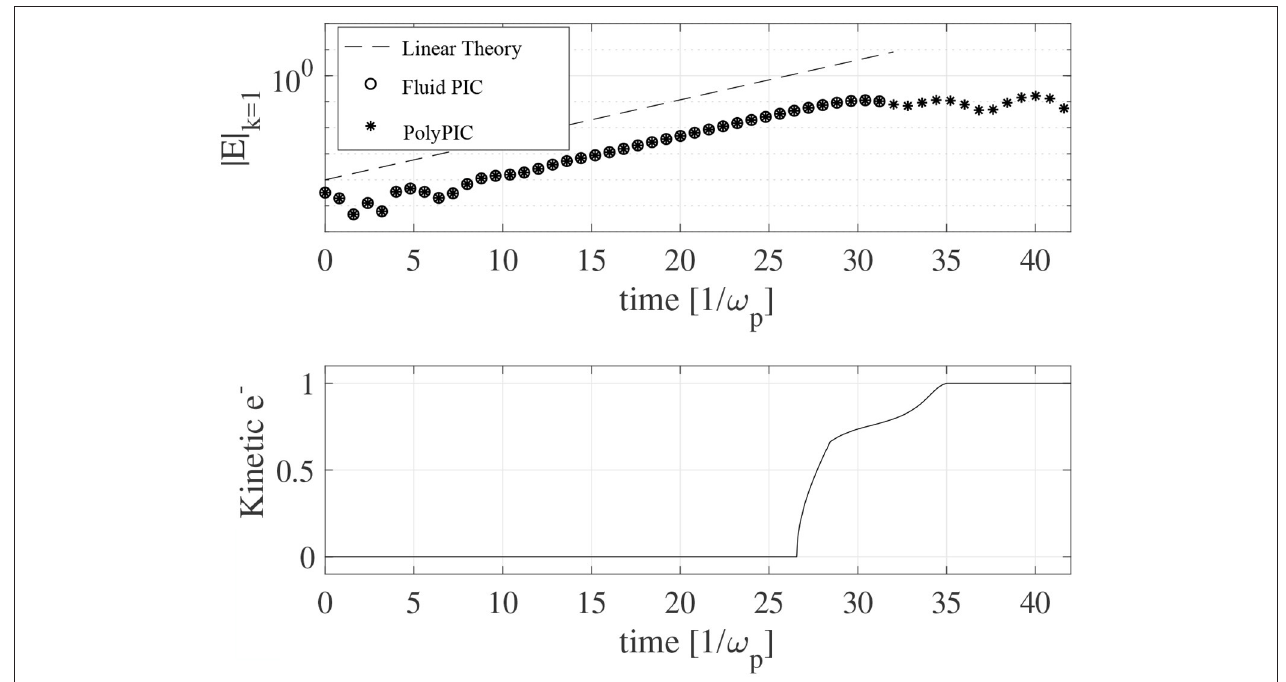
FIGURE 7 | The k 1 spectral component of the electric field is shown for two fluid PIC simulation (open circles), PolyPIC simulation (asterisks) and linear theory = (dashed line) in the top panel. The two fluid PIC simulation becomes unstable during the non-linear stage of the instability. The bottom panel shows the ratio of kinetic electrons over the total number of electrons during the PolyPIC simulation. Initially, all the electrons are fluids; during the non-linear phase of the instability, the electrons become kinetic.